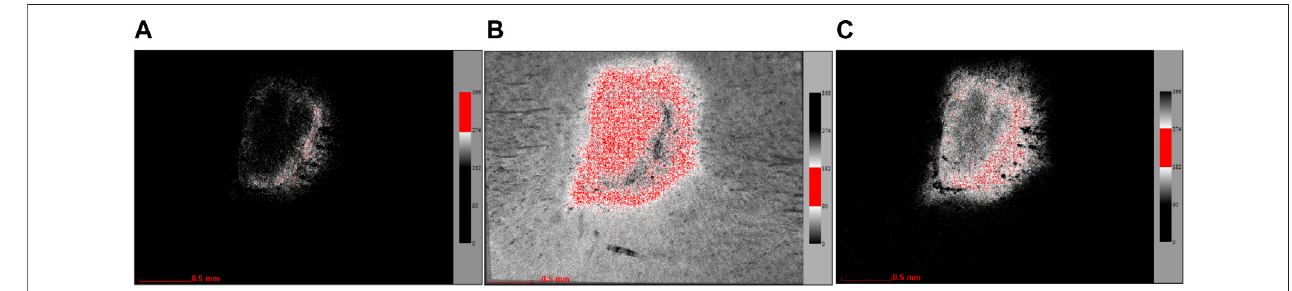
FIGURE 1 | Channel split diagram (the red region is the selected area in the exact channel). (A) Images extracted under the red channel (274 – 366). (B) Images extracted under the blue channel (182 – 274). (C) Images extracted under the green channel (90 –